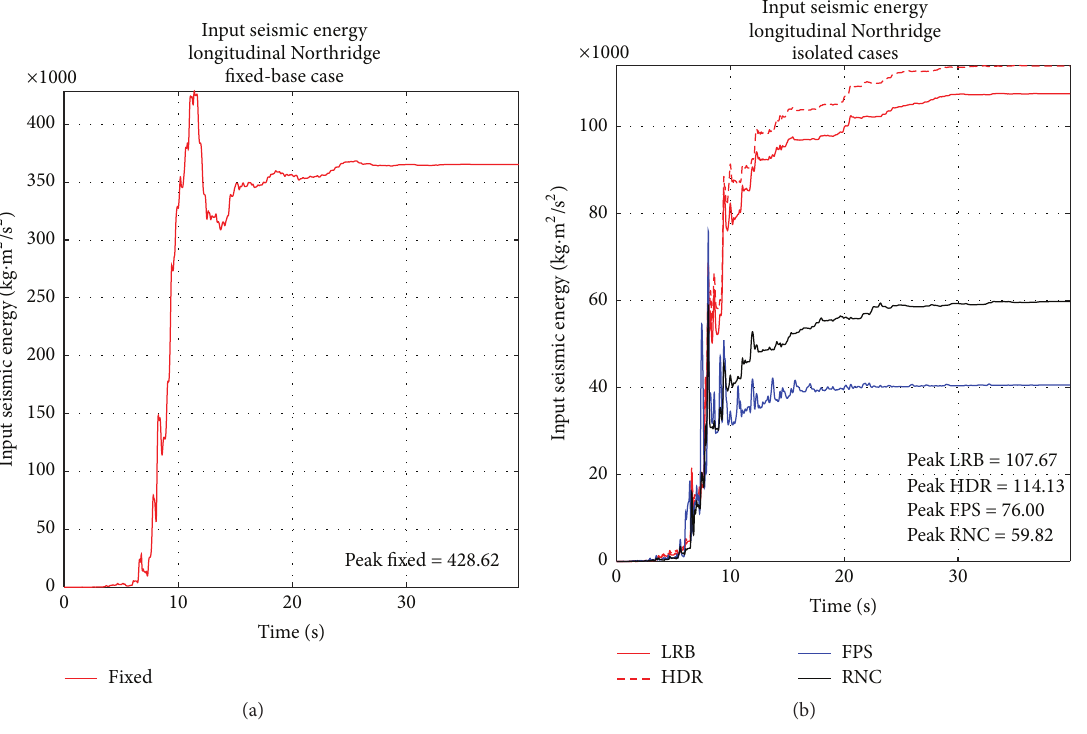
Figure 15: Time history of the input seismic energy due to the longitudinal Northridge earthquake: (a) fixed-base case; (b) isolated cases; kg-m-sec